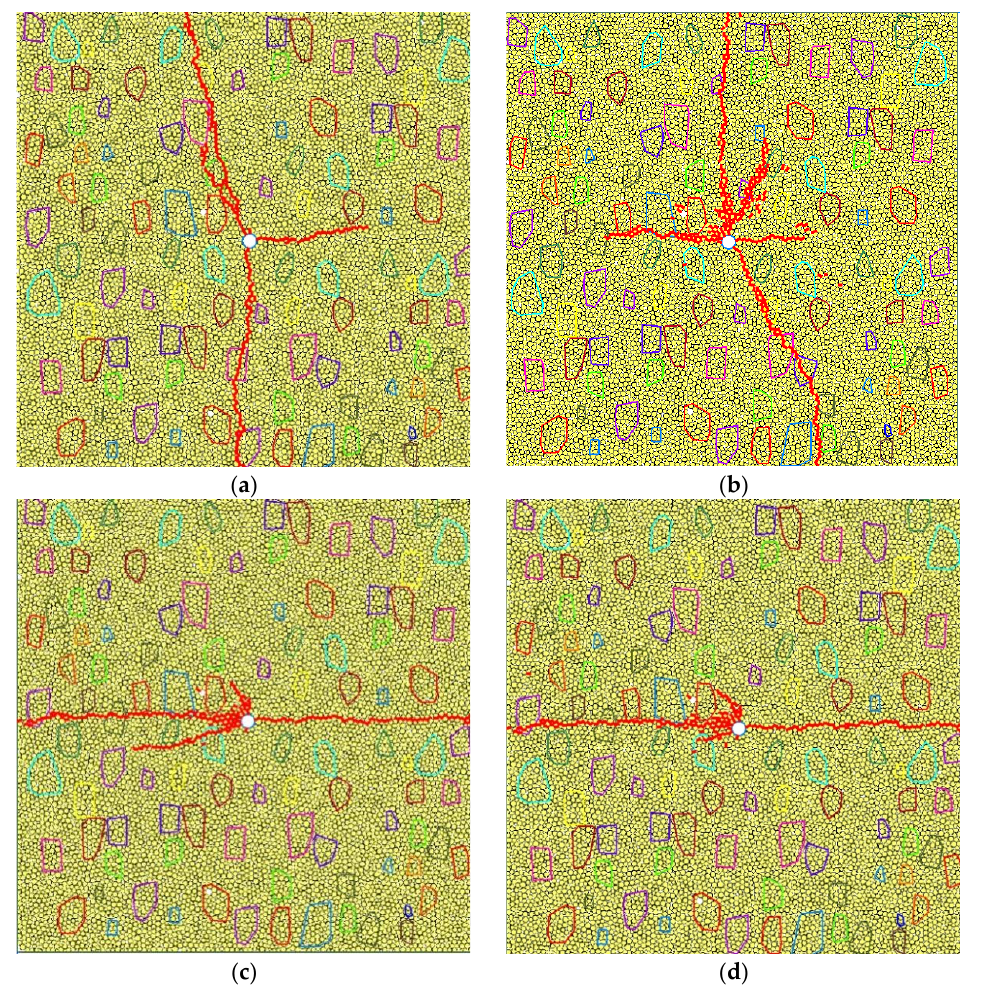
Figure 2. The fracture morphologies under different stress differences. ( a ) σ 1 = 3 MPa, σ 2 = 5 MPa. ( b ) σ 1 = 6 MPa, σ 2 = 5 MPa. ( c ) σ 1 = 8 MPa, σ 2 = 5 MPa. ( d ) σ 1 = 10 MPa, σ 2 = 5 MPa.